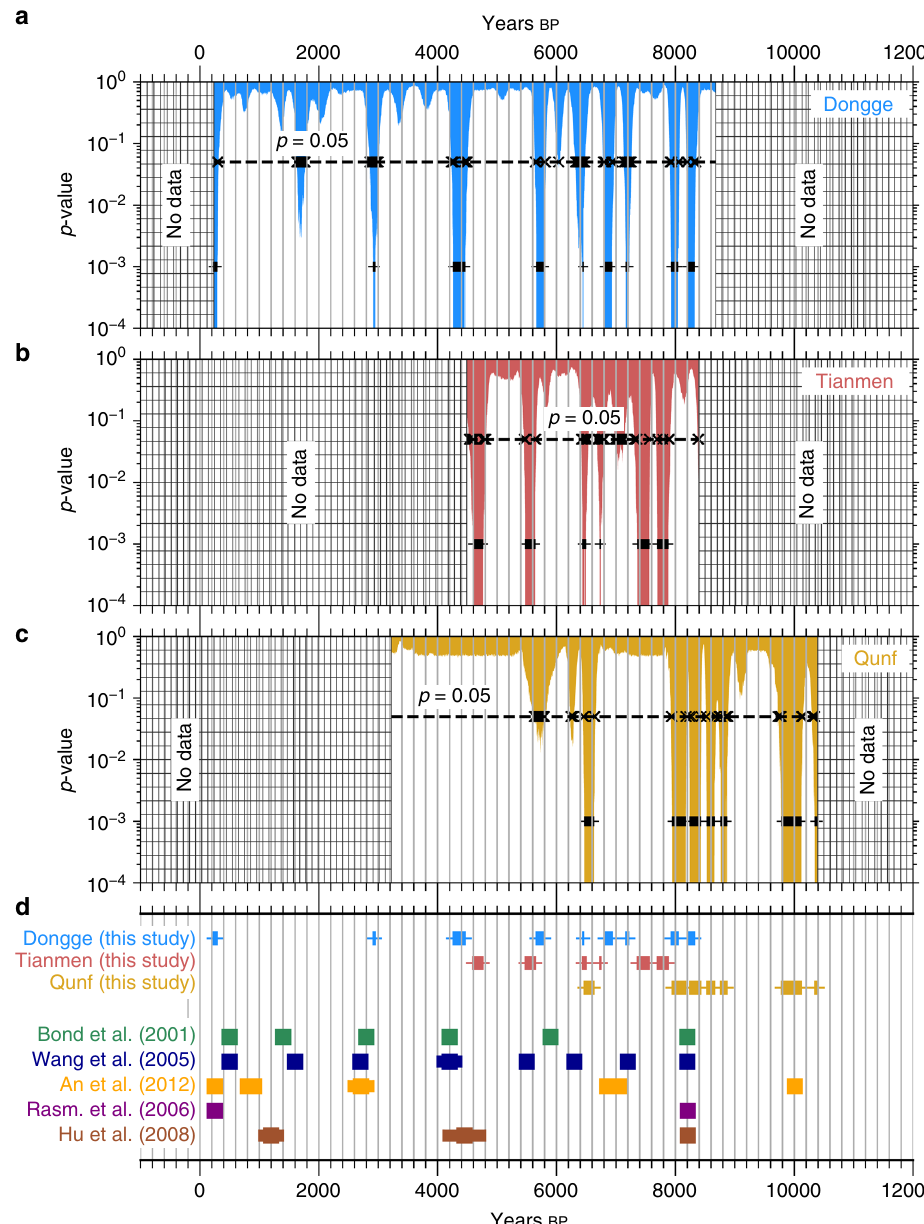
Fig. 5 Abrupt transitions in paleoclimatic datasets. We apply our method to three paleoclimatic δ 18 O proxy records from a Dongge, b Tianmen, and c Qunf caves in Asia. Statistically signi fi cant events (plus signs) show a scatter of events throughout the Holocene, corresponding to periods of weakened ASM (blue squares in ( d )). The weak ASM events are postulated to be synchronous with BEs in the North Atlantic (green squares in ( d )), a hypothesis that we are able to con fi rm with the results from our transition detection analysis. Barring the BE at 1400 yrs BP , all other BEs have a corresponding weak ASM that has been detected. At 1400 yrs BP , the Dongge cave record shows a potential dip in the p -value, but which is not statistically signi fi cant after accounting for multiple comparisons. Note that in ( a – c ), the plus and cross signs, and the horizontal dashed lines denote the same as in Fig.